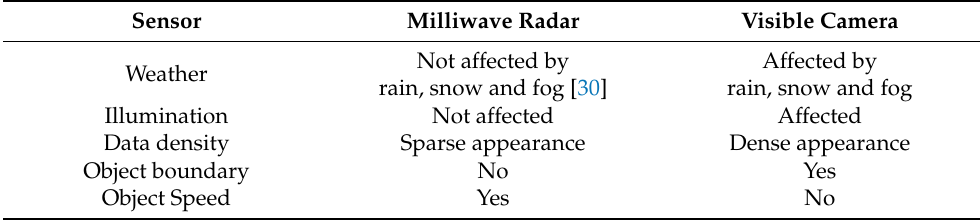
Table 1. Comparative study of the properties of the radar and visible camera.